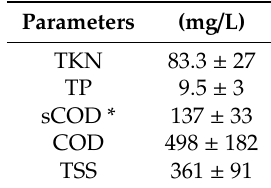
Table 1. Composition of the raw wastewaters used as influents to the cultivation systems.